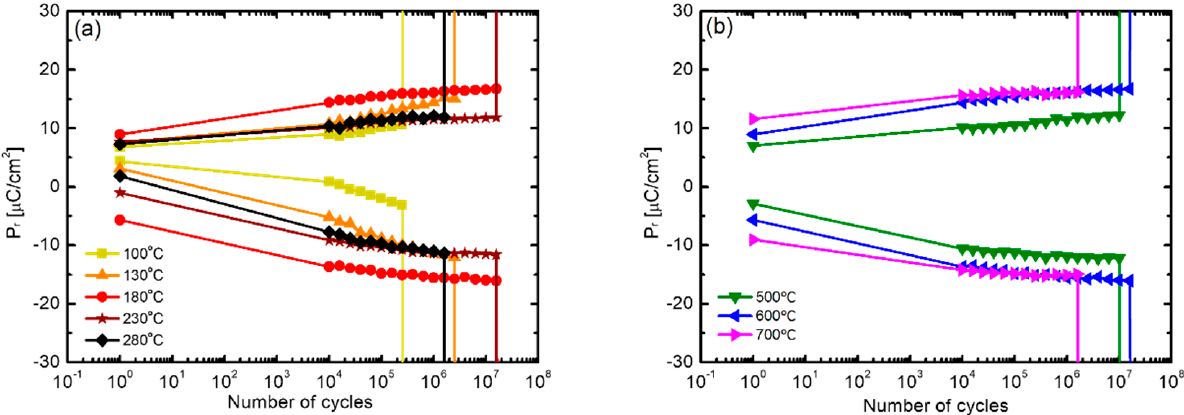
Figure 8. ( a ) Comparison of fatigue endurance of HZO films fabricated at different deposition temperatures after 600 °C annealing and ( b ) comparison of fatigue endurance of HZO films, deposited at a substrate temperature of 180 °C, with respect to annealing temperature.